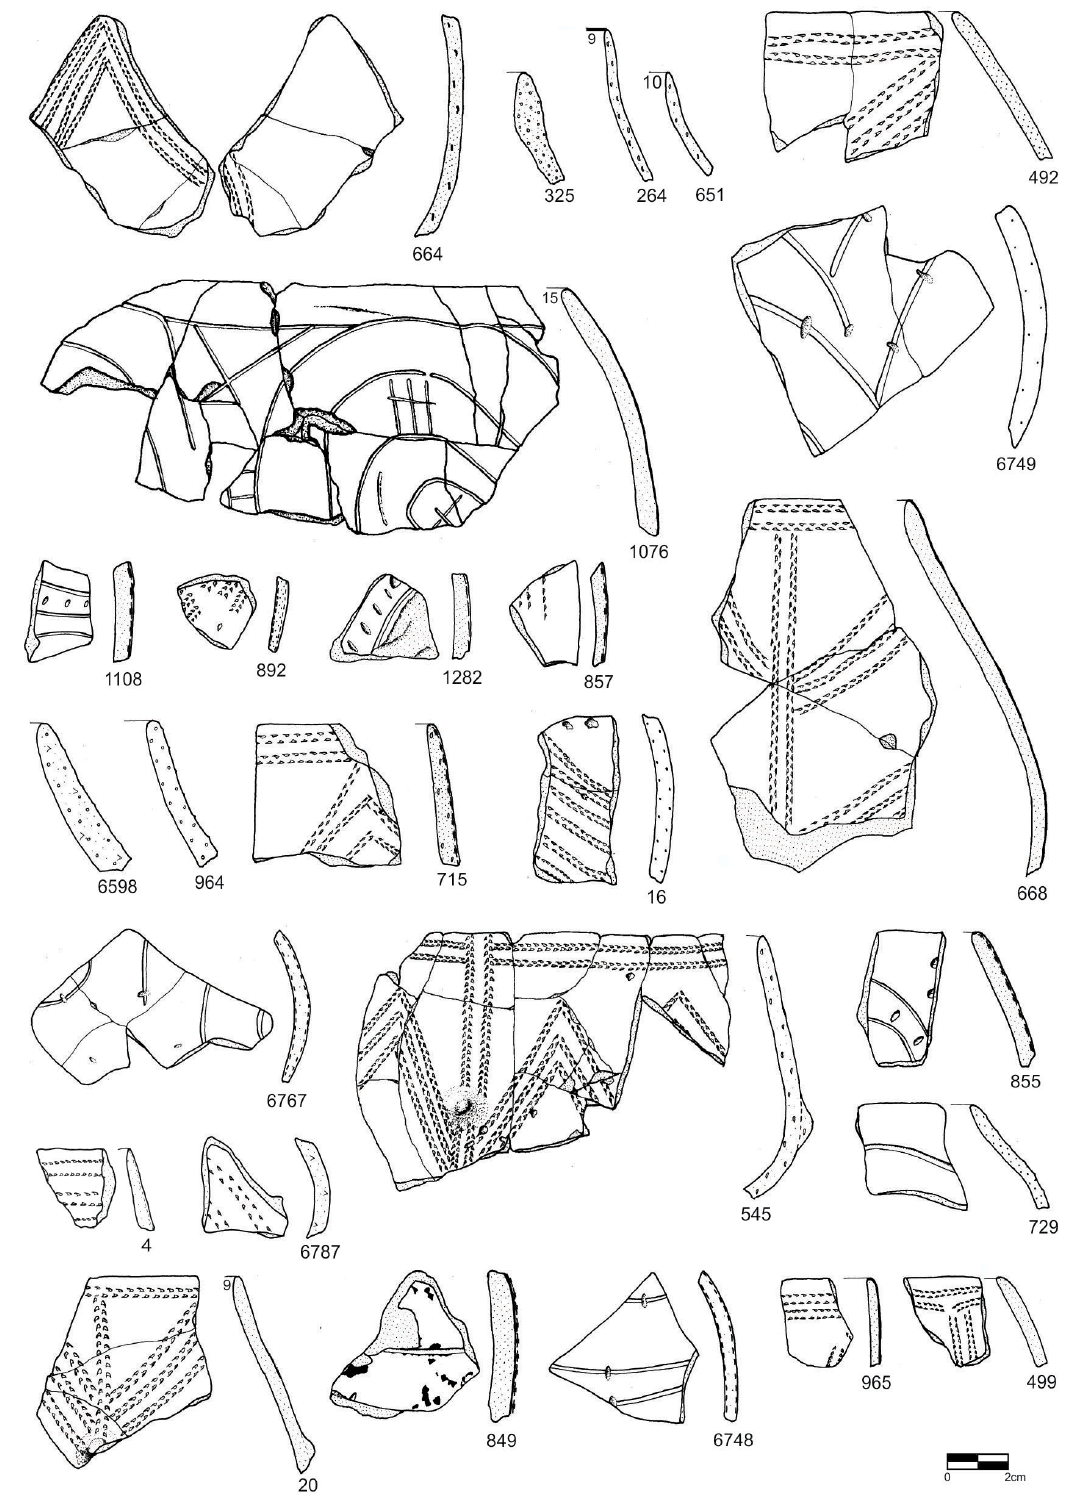
Figure 9. Selected ceramics of Hrdlovka G horizon (drawing M. Divišová, for ceramic fabric and surface treatment graphical codes see Květina & Pavlů 2007, Fig.